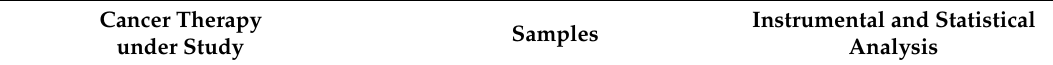
Table 3. Pharmacometabolomic studies performed in